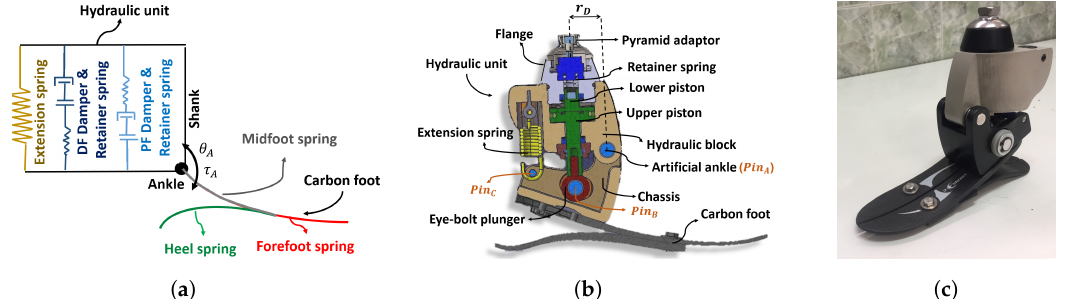
Figure 1. Spring and dampers structure in a simple mechanical model ( a ), CAD representation ( b ), final fabricated model ( c ) of the H2AP. The hydraulic block included DF and PF dampers. DF and PF stand for dorsiflexion and plantar flexion, respectively. The carbon foot comprises three interlocked springs. Ankle torque and ankle angle are shown by τ A and θ A , accordingly.